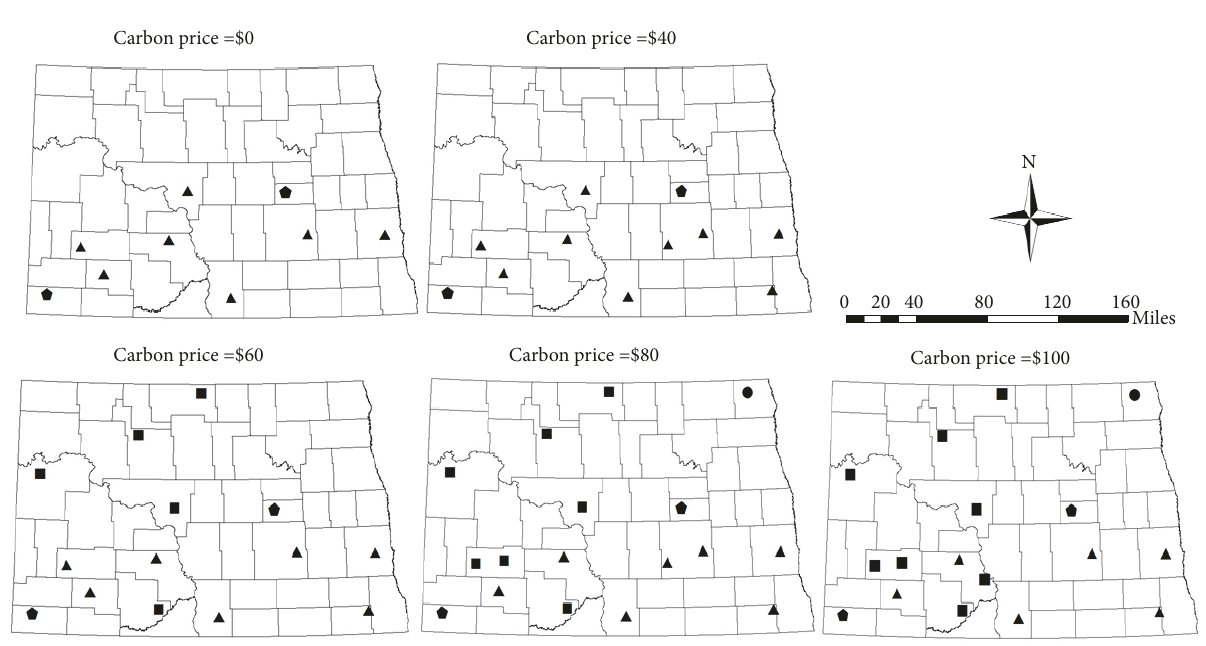
Figure 6: Impact of carbon price on biogas plant locations and